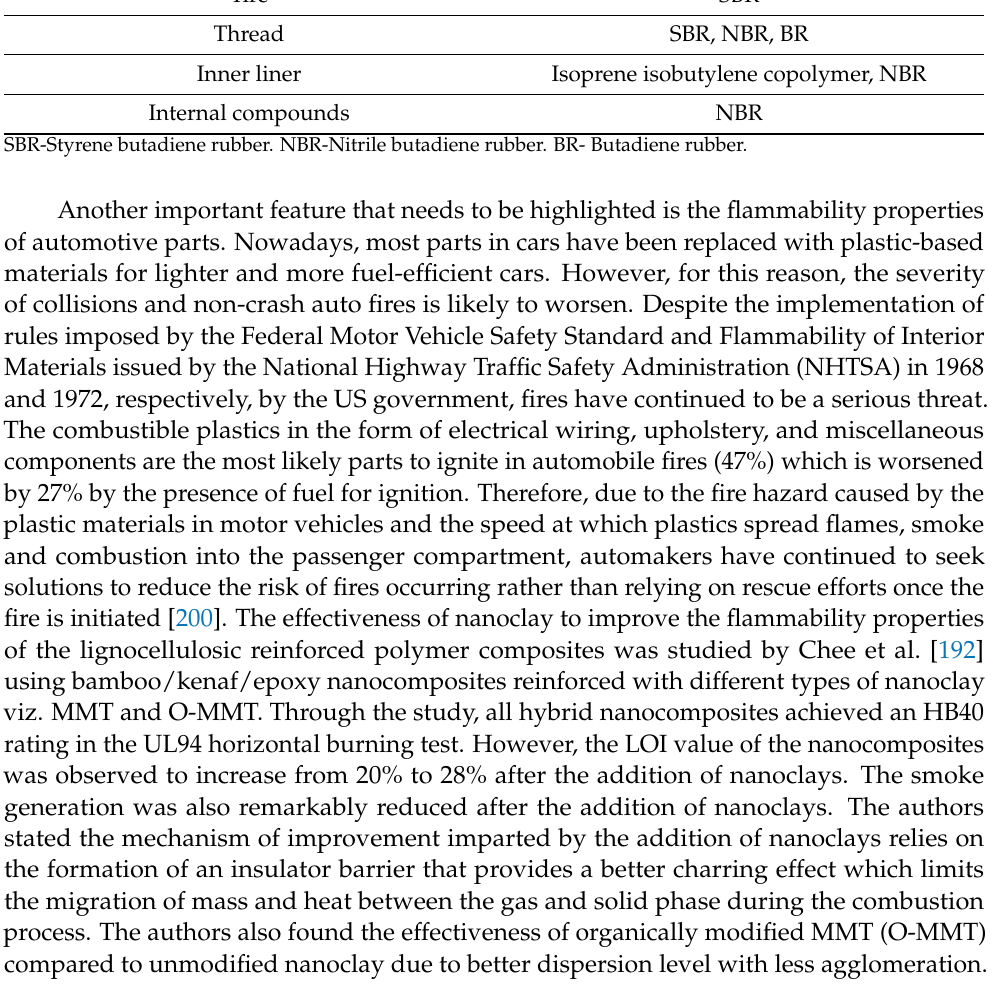
Table 11. Parts of a car and polymer matrices for clay polymer nanocomposite application. Part of Car Polymer Timing belt/engine cover Nylon-6 Step-assist, doors, center bridge, sail panel, seat PP, thermoplastic olefin backs and box-rail protector Rear floor Thermoset polymer matrix (with glass fiber) Tire SBR Thread SBR, NBR, BR Inner liner Isoprene isobutylene copolymer, NBR Internal compounds NBR SBR-Styrene butadiene rubber. NBR-Nitrile butadiene rubber. BR- Butadiene